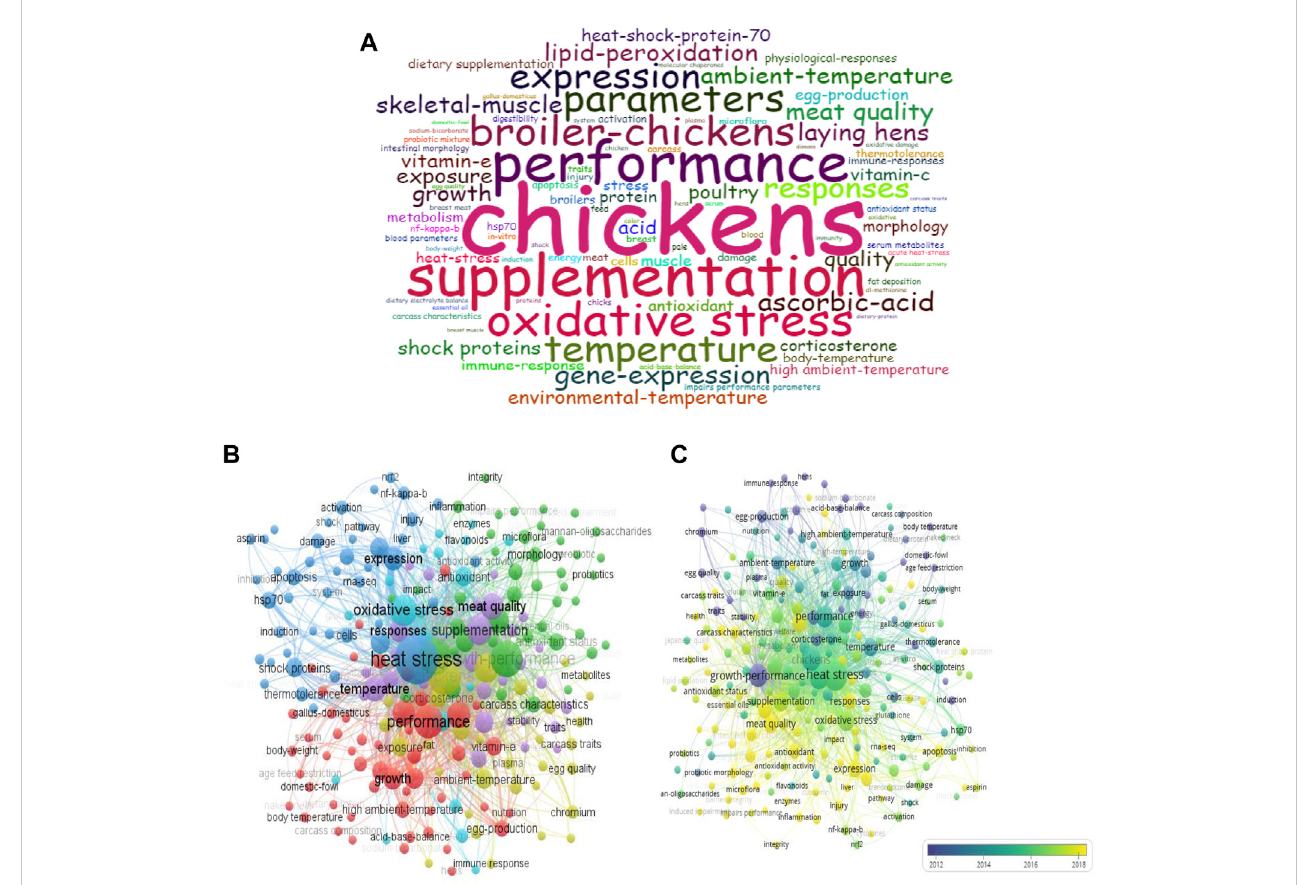
FIGURE 9 Analysis for Keywords associated with global research on heat stress in poultry. (A) Word cloud analysis of Keyword Plus. (B) Network visualization for all keywords co-occurrence. (C) Overlay visualization for the co-occurrence analysis of all keywords.